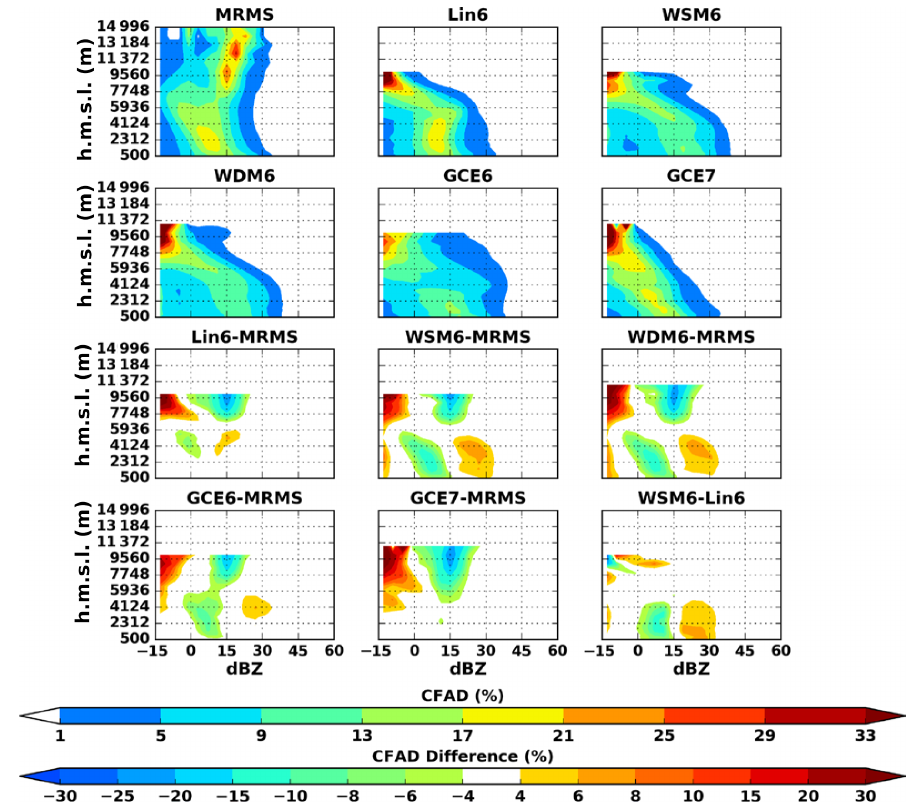
Figure 8. Domain 3 (5km grid spacing), contoured frequency with altitude diagram (CFAD) of radar reflectivity and indicated differences from case 4 (January 2015). Data accumulation period spans 12:00UTC, 26 January 2015–12:00UTC, 27 January 2015 during the transit of the nor’easter through domain 4. The y axis shows height above mean sea level (h.m.s.l.;